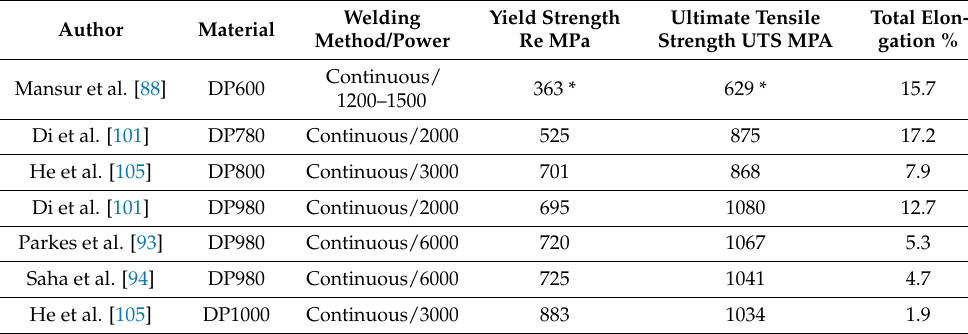
Table 5. Mechanical properties of DP steels weld